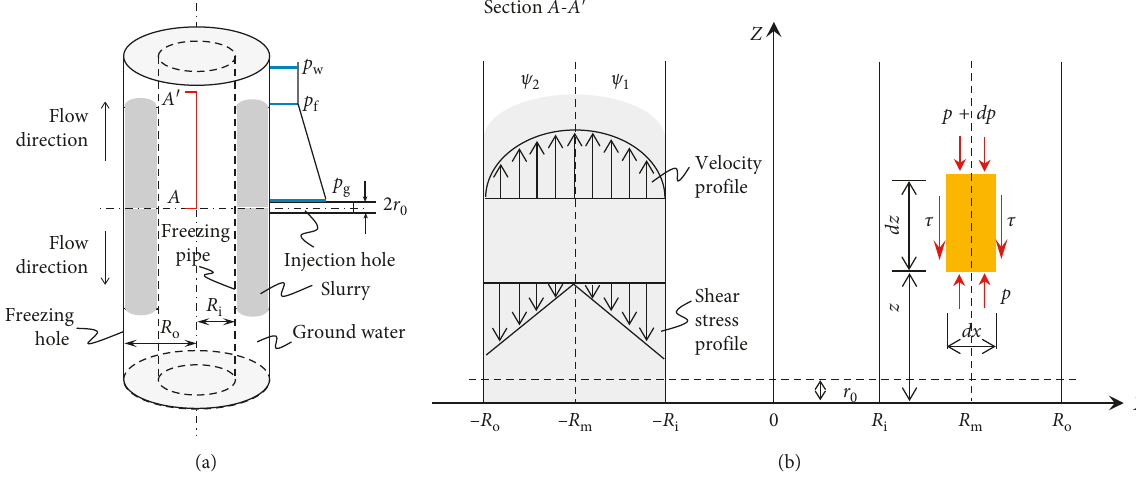
Figure 2: Illustration of fluid flow in an annulus. (a) Grout penetration in a concentric annulus. (b) Force analysis of grout